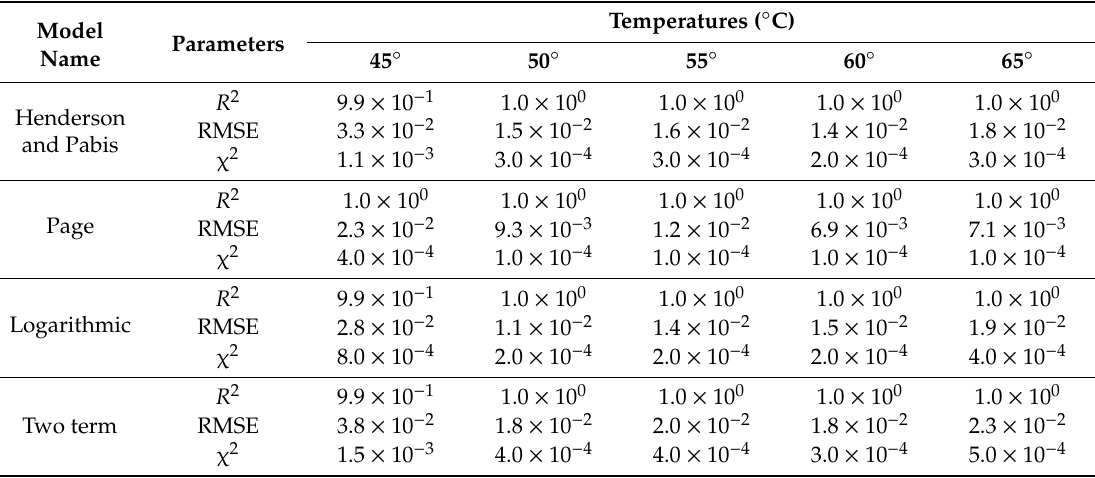
Table 3. Statistical parameters (coe ffi cient of determination R 2 , the root mean square error RMSE, the reduced χ -square χ 2 ) of the drying models.